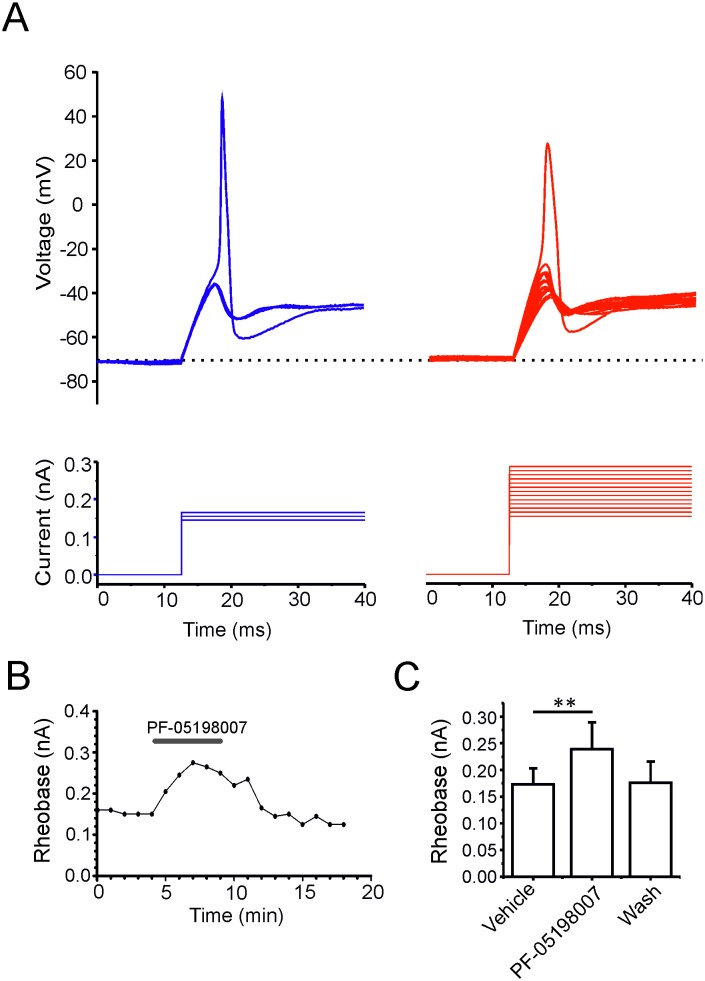
PF-05198007 increases action potential rheobase in small diameter mDRG neurons.A. Overlayed representative voltage traces in response to graded current step injections before (blue) and after PF-05198007 application (red). Current step stimulations are shown below. B. Example timecourse of change in rheobase following PF-05198007 application and washout. C. Summary bar graph, n = 8 neurons, ** p < 0.01, ANOVA. Data are shown ±SEM.